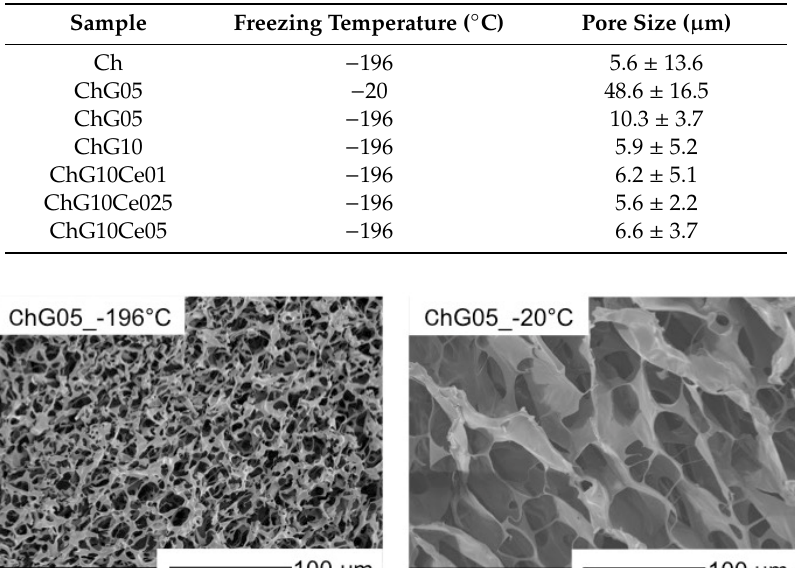
Figure 3. Transverse plane, ( a ) frontal slice (x,z), ( b ) sagittal slice (y,z), ( c ) axial slice (x,y) and 3D reconstruction ( d ) images of chitosan − siloxane hybrid spheres (ChG05, − 20 °C) obtained using micro- CT scan.